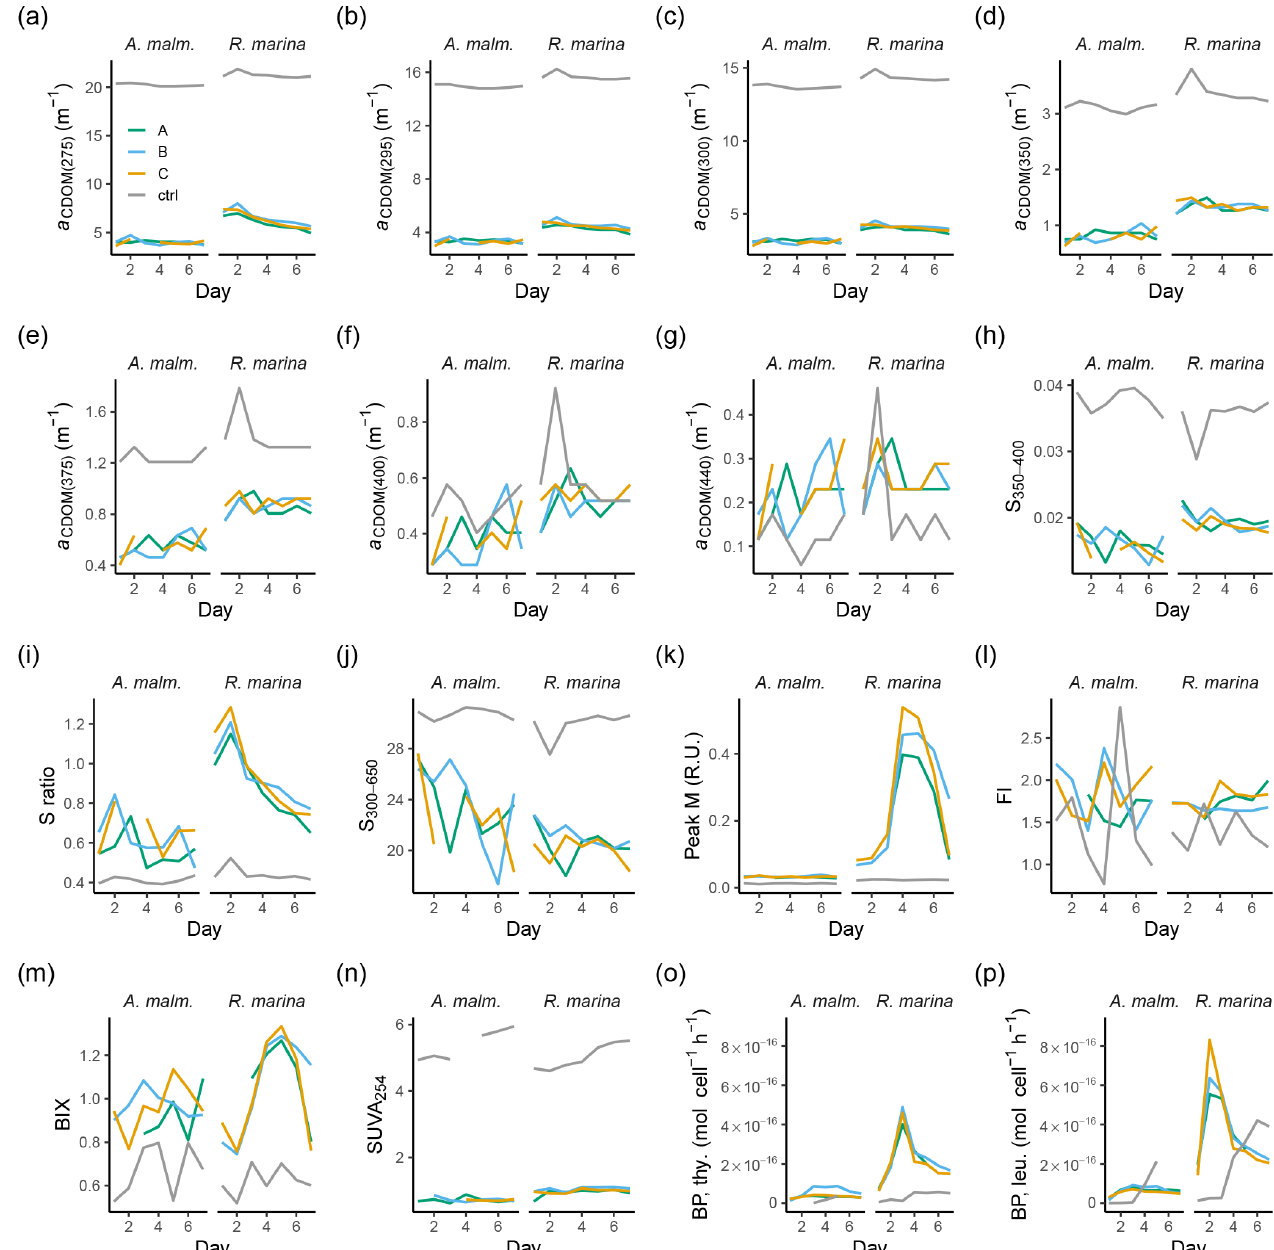
Figure A2. Those CDOM and FDOM variables (a–n) in the DOM consumption experiment, which were measured but not included in the more detailed analysis, and bacterial production measurements (o–p) . (a–g) Absorption coefficients at different wavelengths. (h, j) Spectral slopes between different wavelength ranges. (i) Ratio of spectral slopes between 275–295nm and 350–400nm (Helms et al., 2008). (k) Peak M, marine humic-like DOM (Coble, 1996). (l) FI, fluorescence index (Mcknight et al., 2001). (m) BIX, biological index (Huguet et al., 2009). (n) SUVA254, DOC-normalized absorbance at 254nm (Weishaar et al., 2003). Bacterial production based on thymidine (o) and leucine (p) incorporation. Lines A, B, and C mark different replicates (culture filtrate + seawater bacteria), and ctrl marks the control (F/2 + seawater